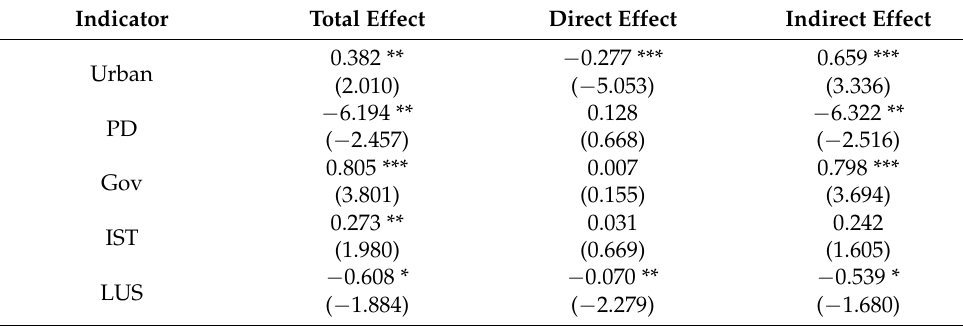
Table 6. Decomposition effect results of spatial Dubin